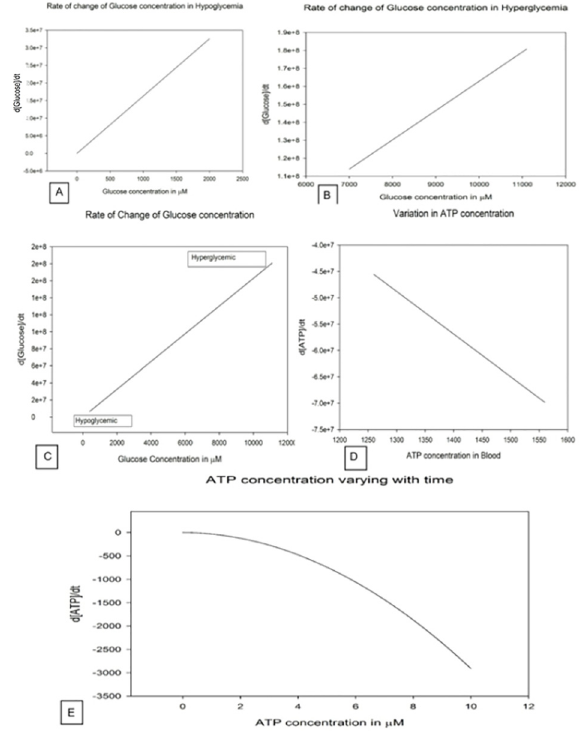
Fig 4. Rate of change of Glucose concentration. A. Illustration of rate of change of glucose concentration with respect to the amount of glucose available in hypoglycaemia. d[Glucose]/dt vs. Glucose concentration in μ M is plot where a straight line is obtained inferring a gradual increase in the Glucose factor with time. The graph has been made available in the Simulation A file in S2 Dataset. B. Illustration of rate of change of glucose concentration with respect to the amount of glucose available in hyperglycaemia. d[Glucose]/dt vs. Glucose concentration in μ M is plot where a straight line is obtained but the hyperglycaemic condition starts when the rate of Glucose factor change comes to 1.1e+8 where the Glucose concentration is near 7000 μ M. The graph has been made available in the Simulation A file in S2 Dataset. C. Illustration of rate of change of glucose concentration with respect to the amount of glucose available, a transition from hypoglycaemia to hyperglycaemia. D. Illustrates the decreasing rate of ATP concentration due to consumption with respect to available ATP concentration. E. Illustrates the initial drop in rate of ATP concentration as it is compensated by the phosphagen system, glycolysis and krebs